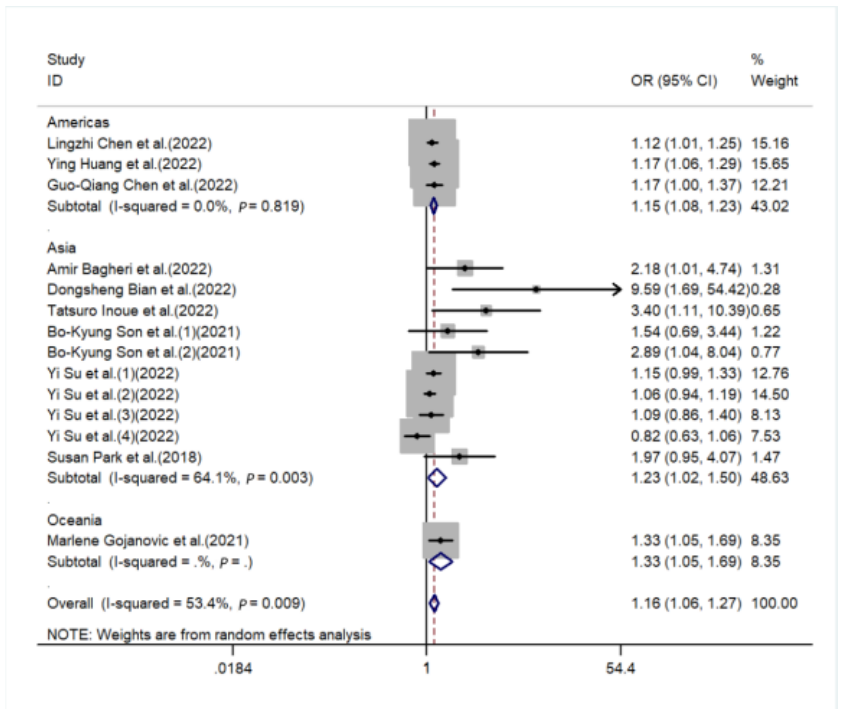
Figure 6. Forest plot for the subgroup of basic disease [19,21,23-29] .